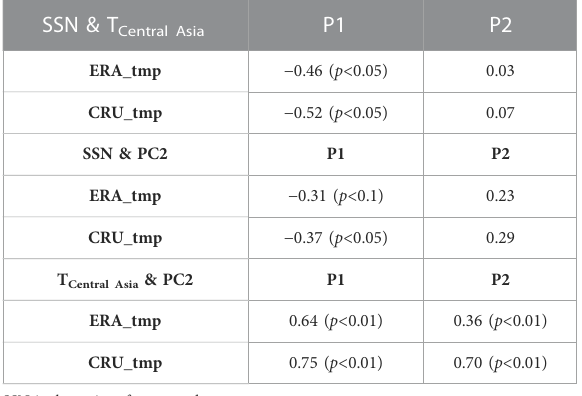
TABLE 2 The correlation coef fi cients between the three variabilities (SSN, T_Central Asia, and PC2) during the two periods of P1 (1951 – 1980) and P2 (1981 – 2010).